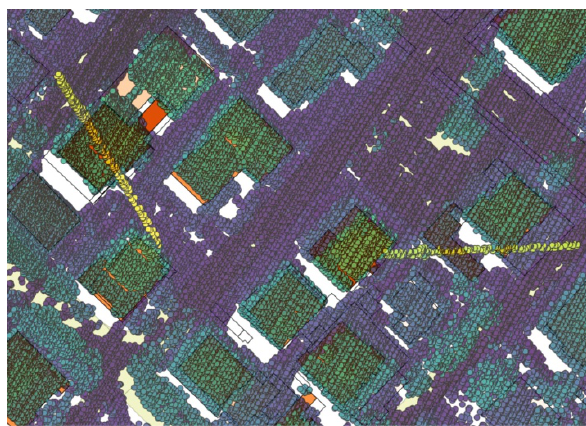
Figure 8. Example of some issues in the datasets: outliers, shift and occlusions.